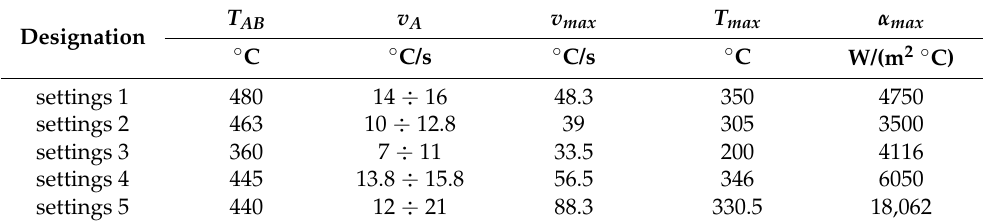
Table 4. Characteristic parameters of quenching